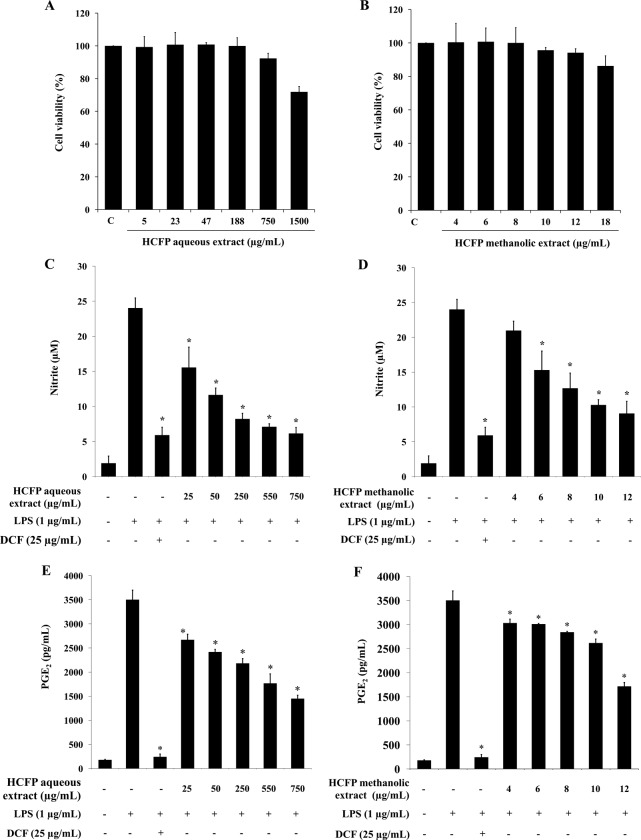
Effect of aqueous and methanolic extracts of HCFP on RAW264.7 cell viability (A, B), NO production (C, D) and PGE2 levels (E, F) in LPS-stimulated RAW264.7 cells. RAW264.7 cells were incubated with aqueous (5–1,500 μg/mL) and methanolic (4–18 μg/mL) extracts for 24 h. Cell viability was assessed by MTT assay. The results were reported as a percentage of cell viability compared with untreated controls and expressed as mean ± S.D. of three independent experiments. For determinations of NO production and PGE2 levels in LPS-stimulated RAW264.7 cells, the cells were pre-treated with indicated concentrations of aqueous (C, E) and methanolic (D, F) extracts for 2 h and then stimulated with LPS (1 μg/mL) for 24 h. The nitrite production and PGE2 levels in cultured medium were determined by using Griess reagent and PGE2 EIA kit, respectively. Statistically significant inhibition of NO production and reduction of PGE2 levels (*p < 0.05) were found as compared with the LPS group. Data were obtained from three and two independent experiments, respectively.